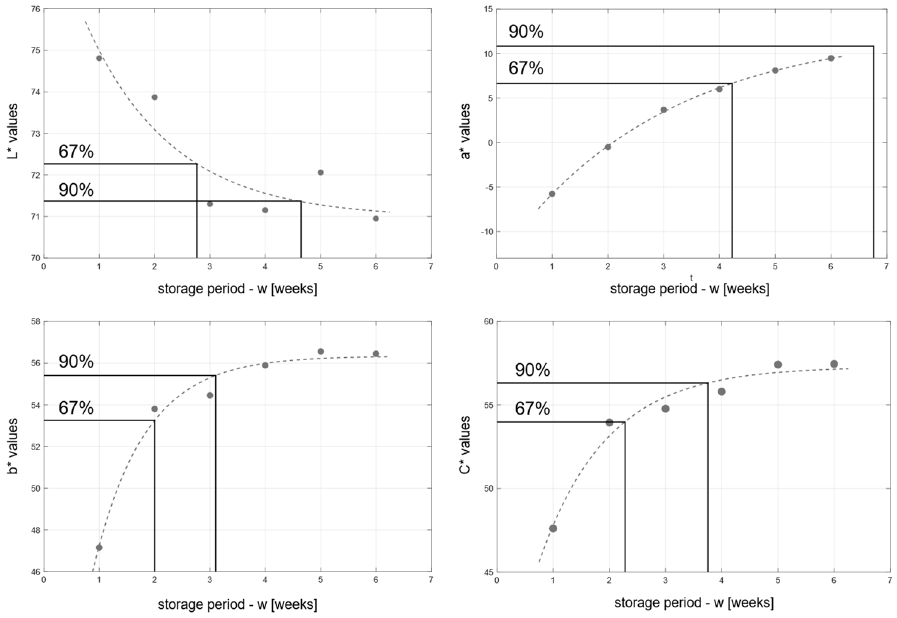
Figure 9. Time constants of color coordinates at 67% and 90% saturation levels during ripening (top left: L*, top right: a*, bottom left: b*, bottom right: C*). left: L*, top right: a*, bottom left: b*, bottom right: